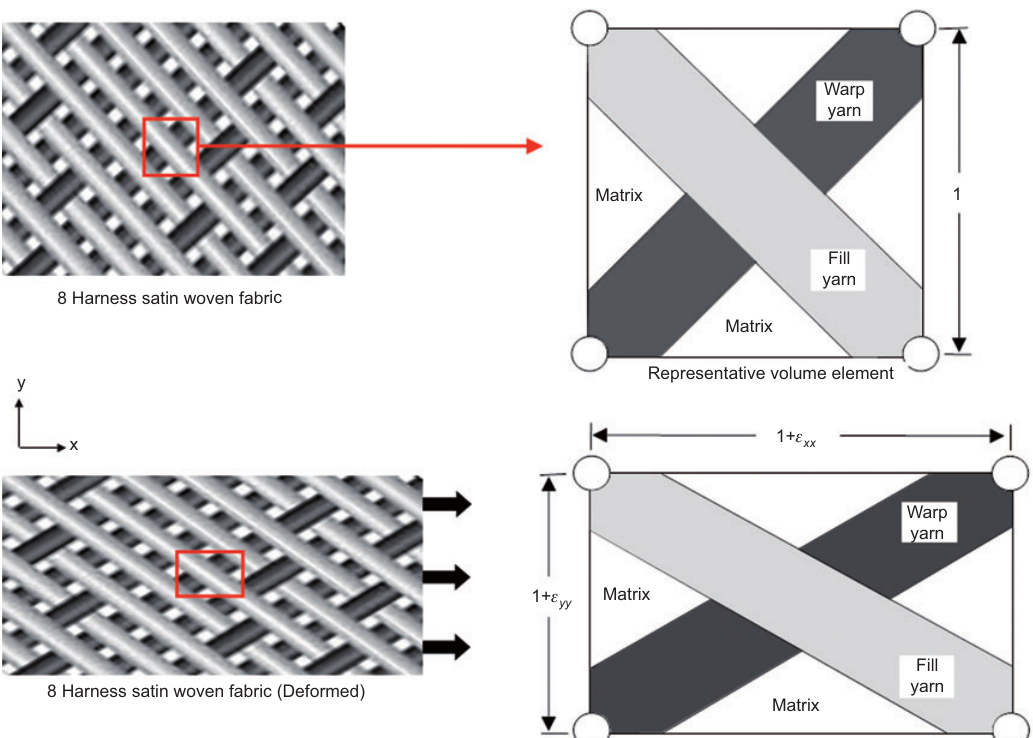
Figure 5 Woven composite